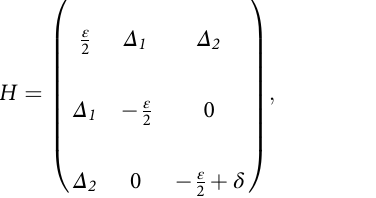
middle, and right dots, ( N L , N M , and N R ,